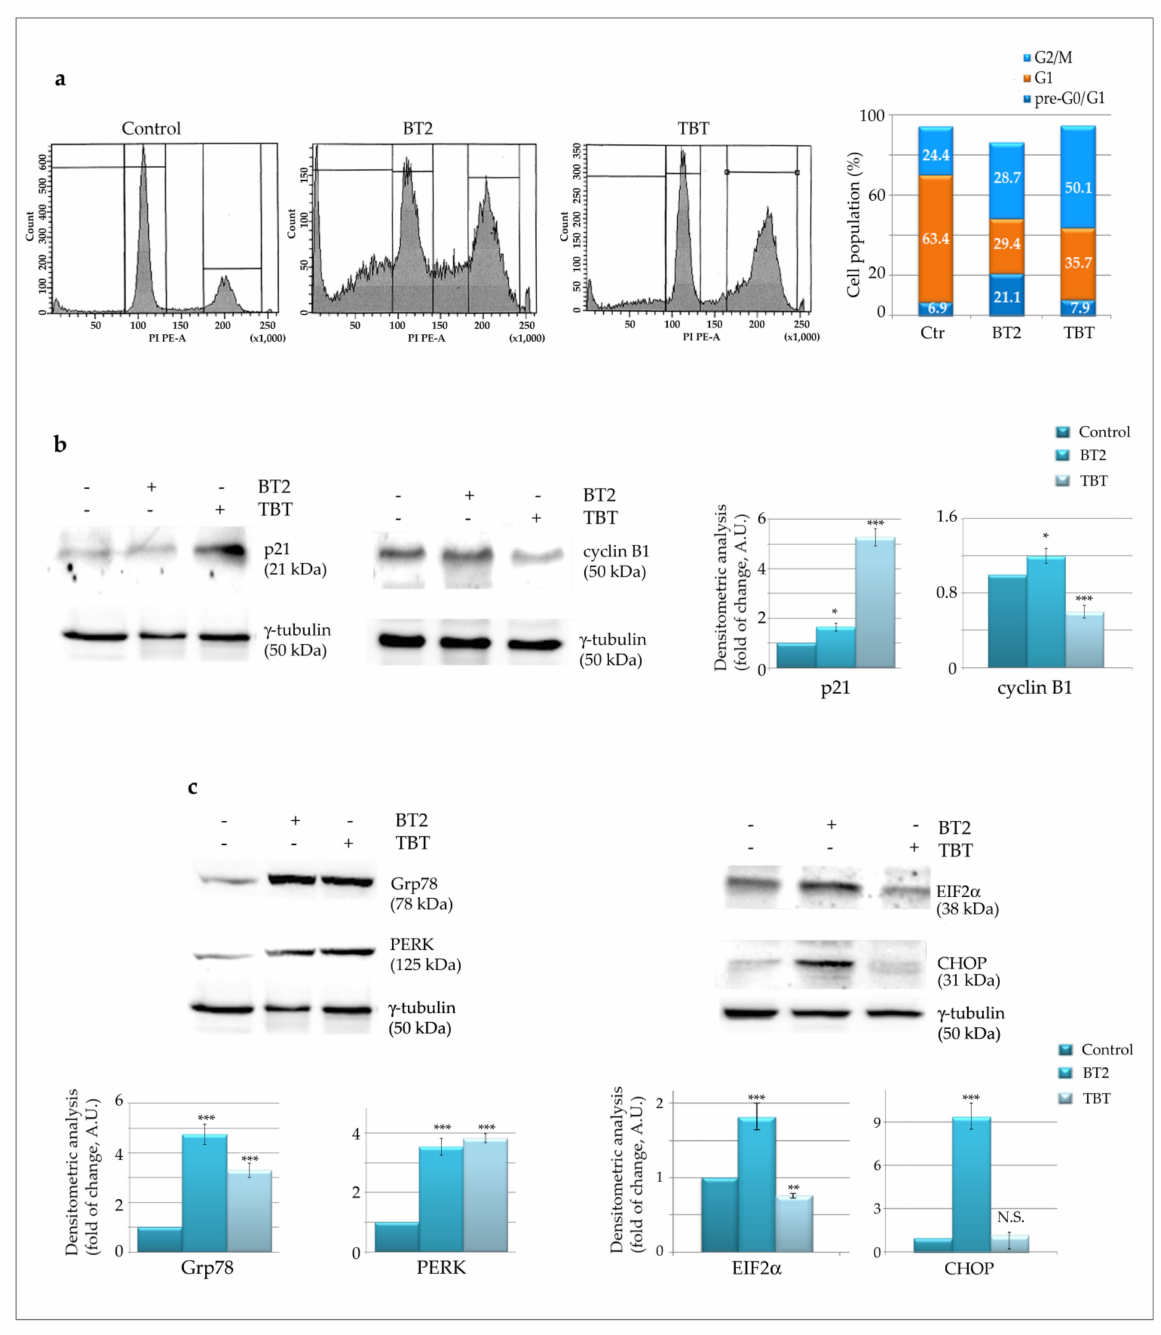
Figure 4. Tributyltin(IV) butyrate (BT2) induces cell cycle arrest accompanied by ER stress induction and DNA fragmenta- tion: ( a ) The cell cycle phase distribution of HCT116 cells was evaluated by flow cytometry analysis. Cells were incubated for 48 h in the presence of 0.5 µ M BT2 or TBT. Then, the DNA content was evaluated after incubating the cells in a hypotonic propidium iodide solution, as described in Section 3. Fluorescence was estimated by FacsDiva Software. ( b , c ) Western blot analysis of p21 and cyclin B1, two proteins differently expressed during the cell cycle phases ( b ), and Grp78, PERK, Phospho eIF2 α , and CHOP markers of endoplasmic reticulum stress ( c ). Cells were incubated for 48 h in the presence of 0.5 µ M BT2 or TBT. The correct protein loading was ascertained by evaluating γ -tubulin levels. Representative blots of three independent experiments and densitometric analysis are shown. (*) p -value < 0.05; (**) p -value < 0.01; (***) p -value < 0.001 compared with untreated cells. N.S. = not